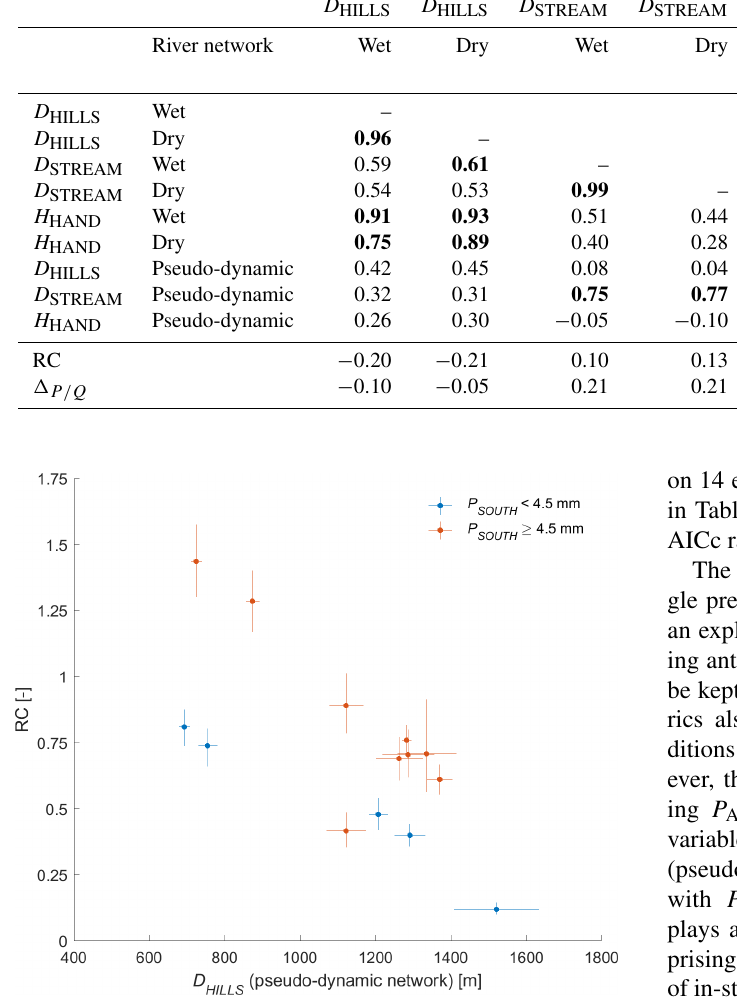
Figure 8. Runoff coefficient against D HILLS , highlighting events with high rainfall amounts in the southern part, i.e., events with P SOUTH > 4 . 5mm. The 24 July event with 3 . 02 < RC < 4 . 85 and D HILLS = 740 ± 140m has been discarded (see Sect.